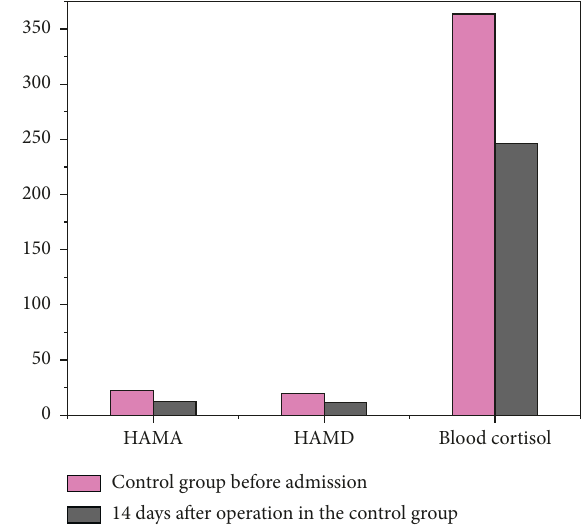
Figure 5: Comparison of perioperative mood changes of patients in the control group (MeanSD).